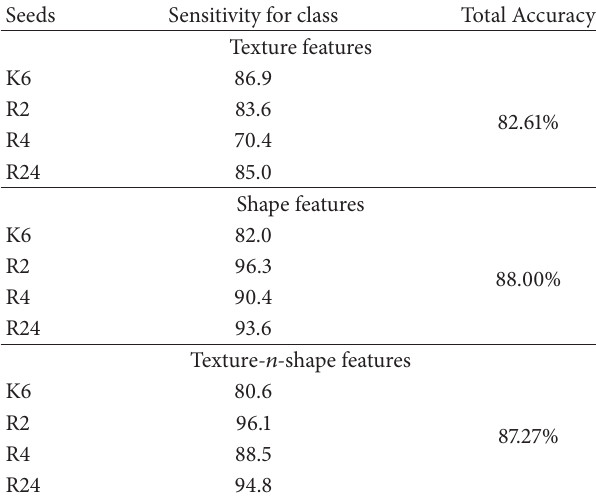
Table 2: Sensitivity for class and Total Accuracy